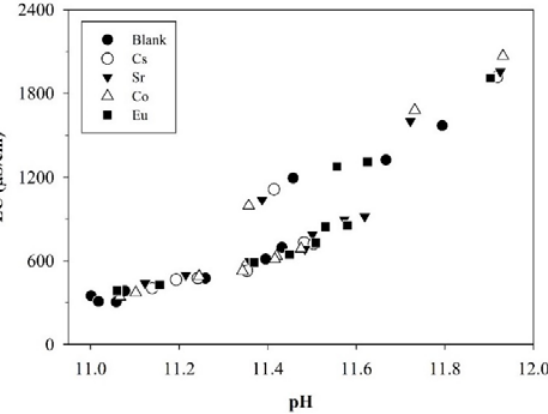
Figure 3. Correlation of pH and electrical conductivity (EC) for each leachate.